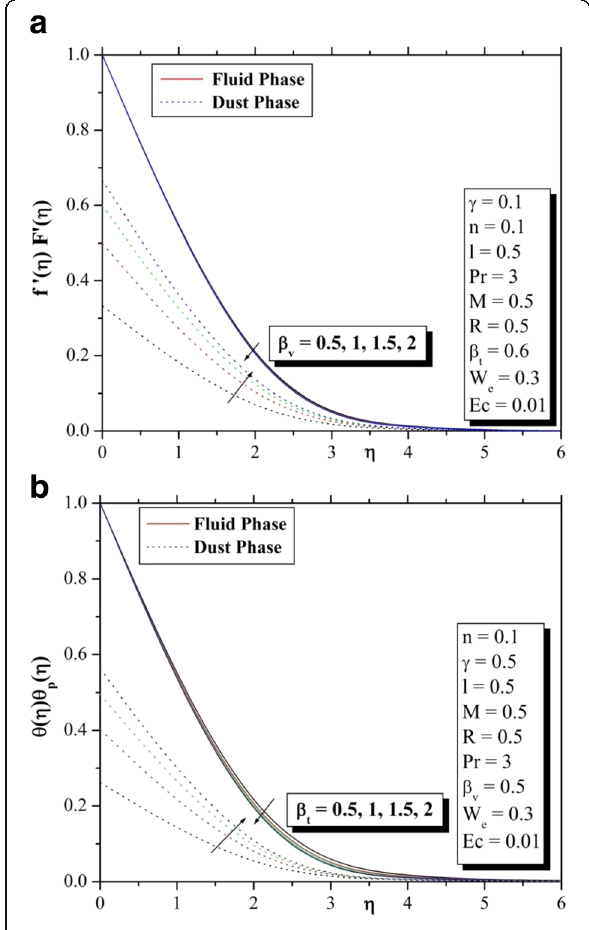
Fig. 5 a , b Velocity profile and temperature profile for different values of β v and β